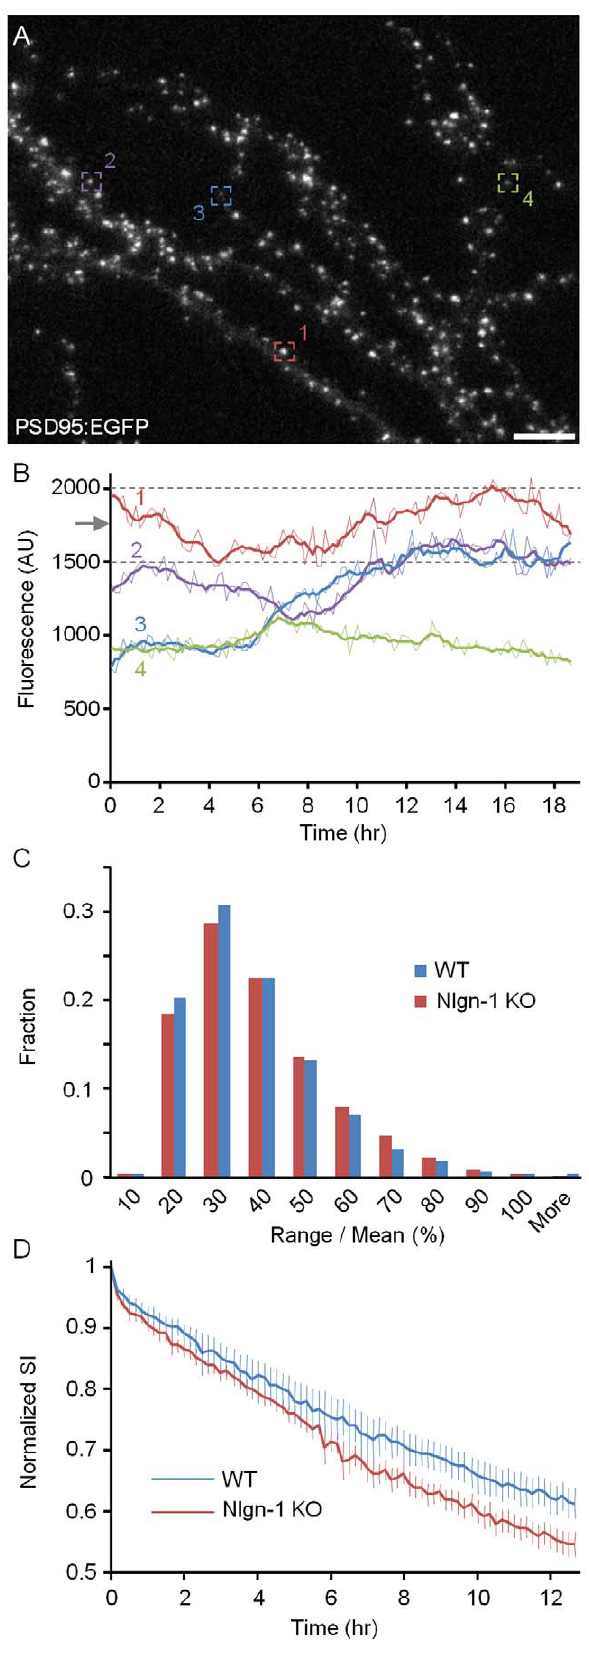
Figure 3. Constancy of PSD-95:EGFP contents at individual synapses. A ) Dendrites of a neuron from a Nlgn-1 KO mouse expressing PSD-95:EGFP (23 days in vitro ). Full time lapse sequence of this region is shown in Video S1. Bar, 10 m m. B ) Changes over time in the fluorescence intensity of four puncta (enclosed in numbered and color coded rectangles) over . 18 hours. Raw data is shown as thin lines whereas thick lines show the same data after smoothing with a 5 point low pass filter. A calculation of the range over mean measure is illustrated for punctum # 1: the dashed lines show the minimal and maximal values of the smoothed data and the arrow indicates the mean fluorescence intensity over the imaging period. C ) Distribution of range over mean values for all PSD-95:EGFP puncta measured in these experiments (Nlgn-1 KO: 46 neurons, 3465 puncta; WT: 44 neurons, 3367 puncta). D ) SI decay rates measured in neurons from Nlgn-1 KO and WT mice (mean 6